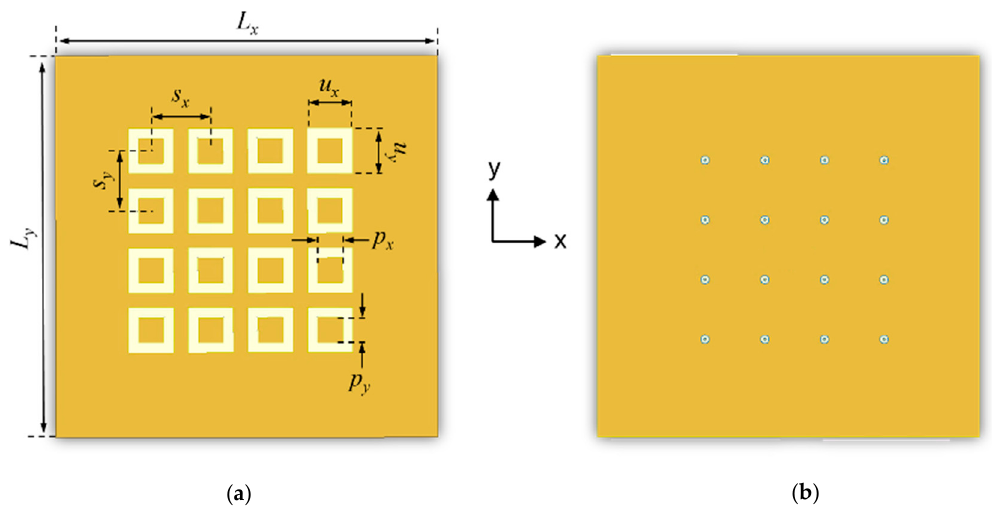
Figure 9. ( a ) Top and ( b ) bottom views of the 4 × 4 patch antenna array to use as a source for lens